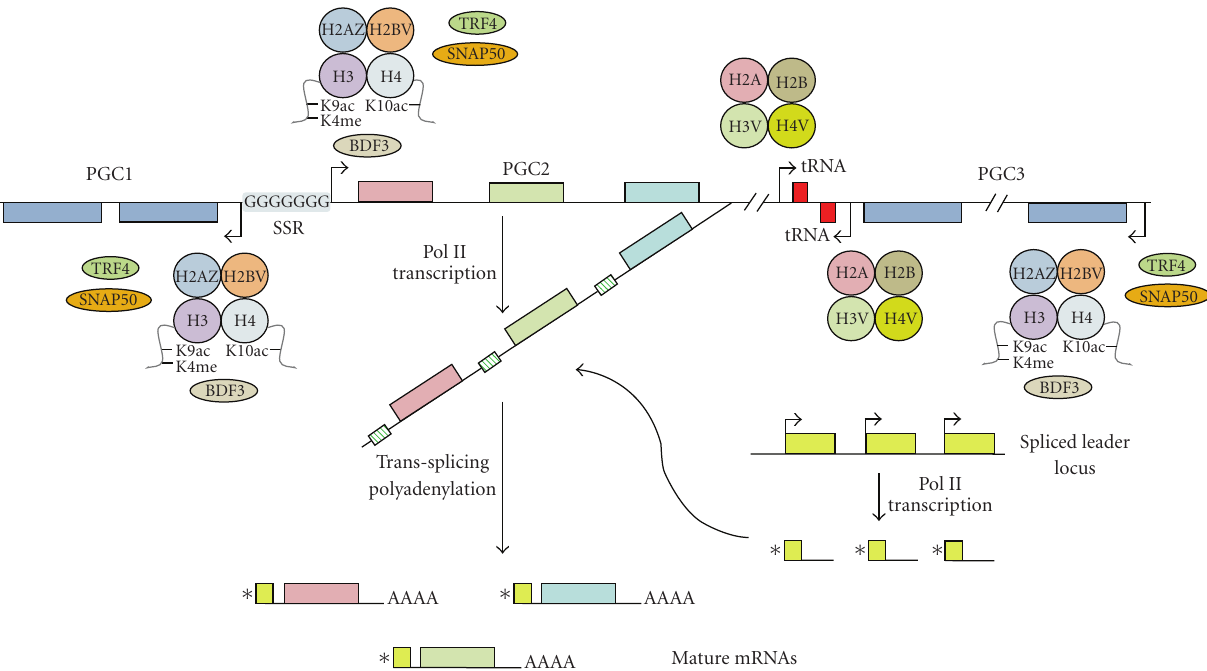
Figure 1: Transcription and processing of mRNAs in trypanosomatids. The top part of the figure represents a hypothetical chromosome with three polycistronic gene clusters (PGC1-3). Pol II transcription initiates upstream of the first gene of the PGCs (arrows) [29, 38]. The G-run usually present at divergent strand-switch regions (SSR) is indicated. Nucleosomes located at the vicinity of transcription initiation regions contain histone variants H2AZ and H2BV [39]. The N-terminal tail of histone H3 in such nucleosomes are acetylated at K9/K14 (labeled as K9ac in the figure) and tri-methylated at K4 (K4me) [40, 41]. The N-terminal tail of histone H4 is acetylated at K10 (K10ac) [39], and at K5/K8/K12/K16 [41] (not shown in the figure). The bromodomain factor BDF3 [39], and transcription factors TRF4 and SNAP50 [40] also bind at transcription initiation regions. Pol II transcription of some PGCs terminates near tRNA genes (convergent strand-switch region between PGC2 and PGC3) [38], in regions of DNA that contain nucleosomes with histone variants H3V and H4V [39]. Transcription of a PGC produces a primary transcript (shown only for PGC2) that is processed by trans-splicing and polyadenylation to generate the mature mRNAs. By trans-splicing, a capped SL RNA (yellow box) is added to the 5 (cid:2) end of every mRNA. In the spliced leader locus (located in a di ff erent chromosome) each gene possesses a Pol II promoter region (arrows). The cap in the SL RNA is indicated by an asterisk at the 5 (cid:2) end of the RNA. The polycistronic transcript contains pyrimidine-rich regions (indicated by a striped box in the intergenic regions) that are needed for both trans-splicing and polyadenylation. The pyrimidine-rich regions are also present in the DNA, but they are not shown to simplify the figure. The four As located at the 3 (cid:2) end of the mature mRNAs represent the poly-A tail.